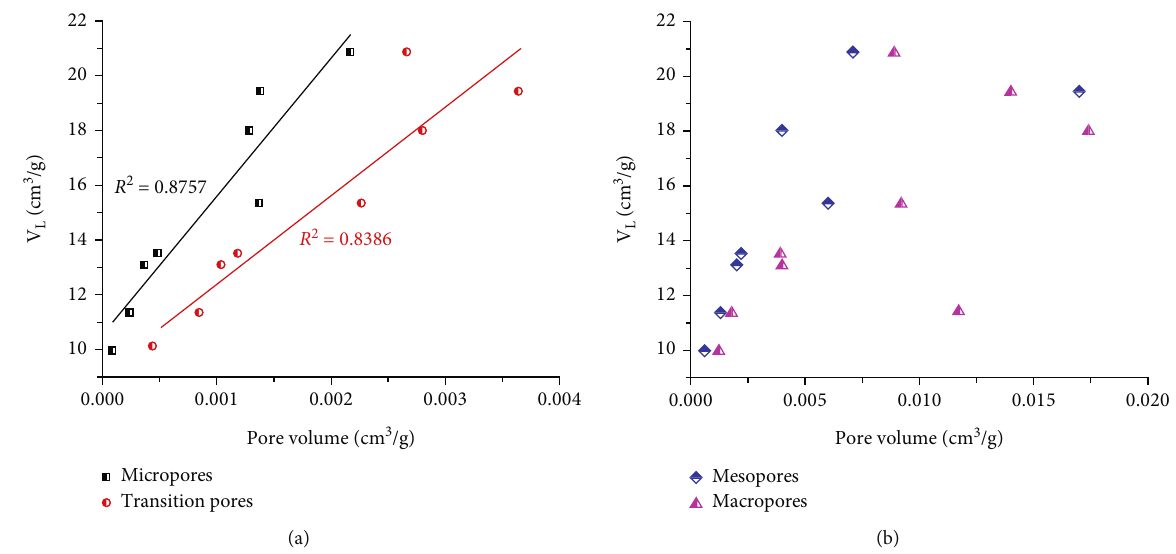
Figure 10: Correlations between the maximum methane adsorption capacity and pore volume of micro- and transition pores (a) and meso- and macropores (b).